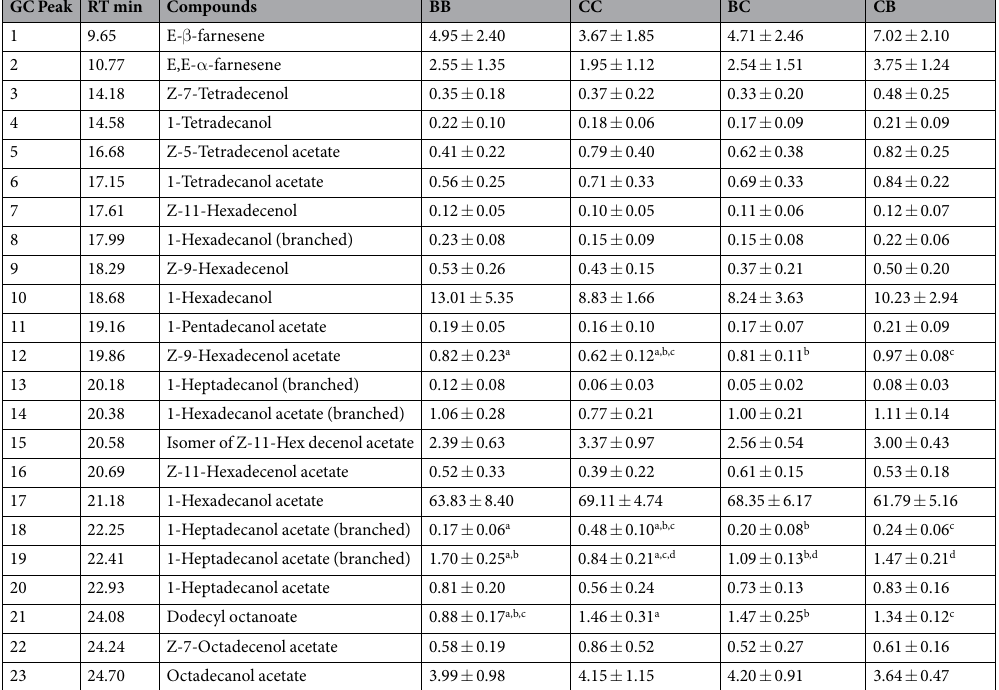
Table 1. Relative abundance of preputial gland volatiles in the four groups. Data are presented as mean ± SD, n = 6 for each group; compounds were identified using mass library (NIST 2002). a–e Means in a row marked by a same superscript letter show significant differences ( P < 0.05, using one-way ANOVA with LSD post hoc t-test or Kruskal–Wallis H with post hoc Mann–Whitney U test). BB: BALB/c strain; CC: C57BL/6 strain; BC: hybrid of BALB ♀ × C57 ♂ ; CB: hybrid of C57 ♀ × BALB ♂ ; RT: retention